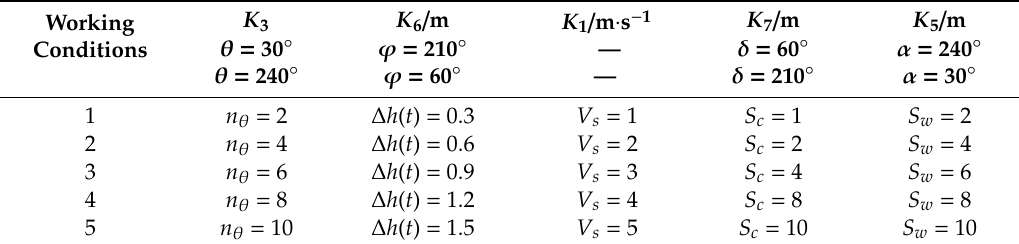
Table 4. Angle groups and working conditions.